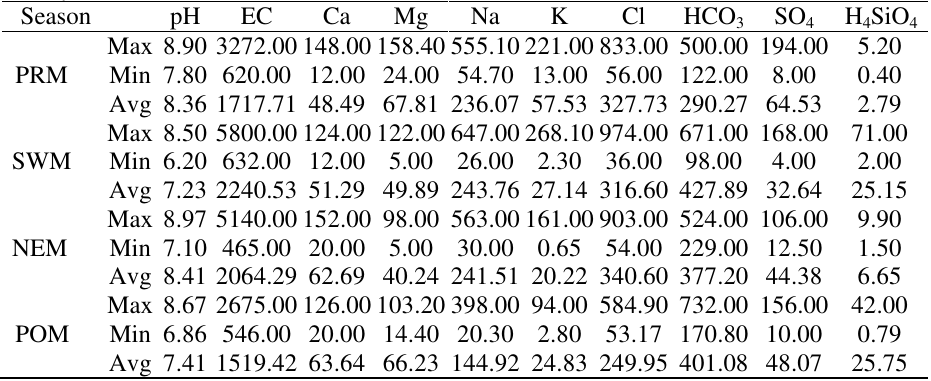
Table 1 . Summary of water chemistry (all values in ppm except EC in µ s/cm and pH)